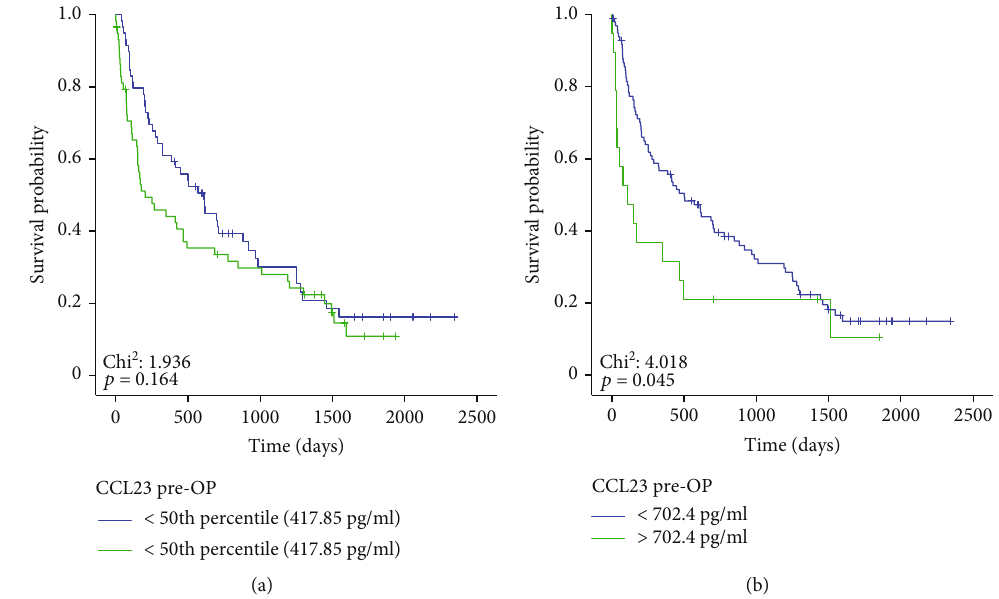
Figure 3: Elevated preoperative CCL23 levels are associated with an impaired outcome. (a) BTC patients with a preoperative CCL23 level above the 50 th percentile show a trend towards an impaired overall survival (OS) following tumor resection. (b) BTC patients with preoperative CCL23 serum levels above the optimal prognostic cut-o ff value (702.4.93pg/ml) have a signi fi cantly reduced OS compared to patients with serum levels below this cut-o ff